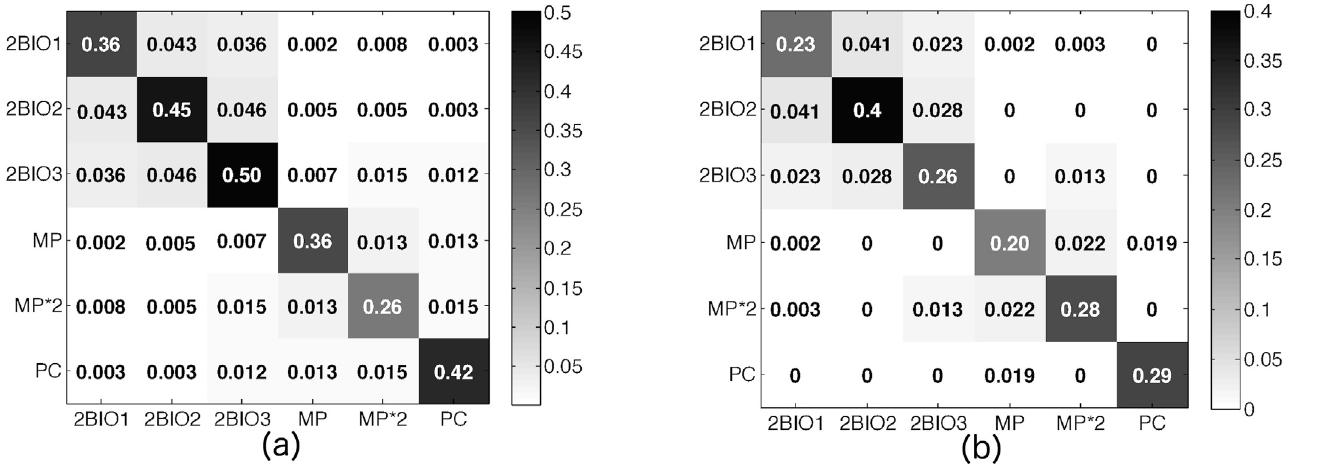
Fig 3. Contact matrices of edge densities. The entry at row X and column Y of the matrix is given by the total number of links between students in class X and students in class Y , normalized by the maximum number of observable links ( n X n Y or n X ( n X − 1)/2 if X = Y , with n X the cardinality of the class X ) giving the edge link densities for (a) the contact sensors network and (b) the matched contact diaries network, both limited to the 6 classes considered. The cosine similarity between the two matrices is equal to 97%.